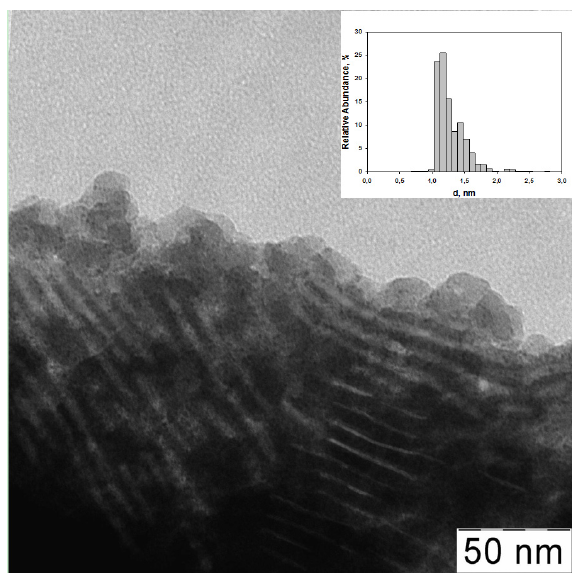
Figure 3. G2-dendr- meso -SiO 2 -Ru catalyst: TEM microphotography and particles size distribution.